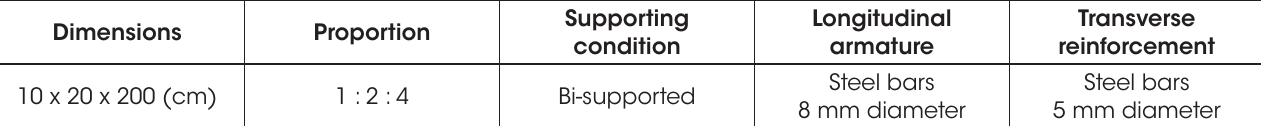
Constructive parameters of the concrete beam Dimensions Proportion